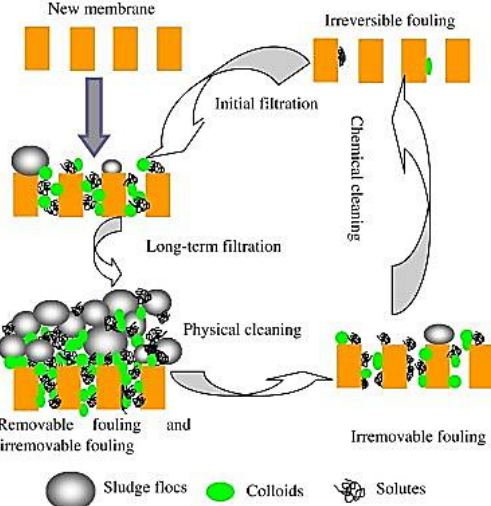
Figure 5. Reversible, irreversible and irrecoverable fouling in membrane processes. Reprinted from [92], with permission from Elsevier.